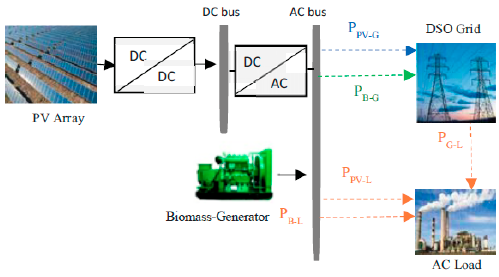
Figure 1. Proposed Photovoltaic (PV)-Biomass Generator on-grid system.